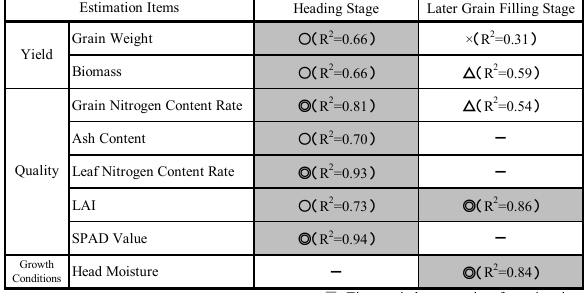
Table 6: Determination Coefficient Analysis